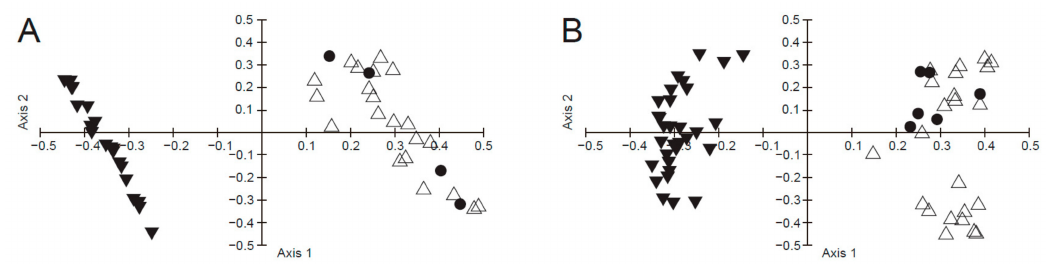
Figure 1. Principal coordinate analysis of Pyrus hopeiensis , P. ussuriensis and P. phaeocarpa based on morphological characters. ( A ) specimens of flowering period, ( B ) specimens of fruiting period. Black triangles: P. phaeocarpa , white triangles: P. ussuriensis , black circles: P. hopeiensis .